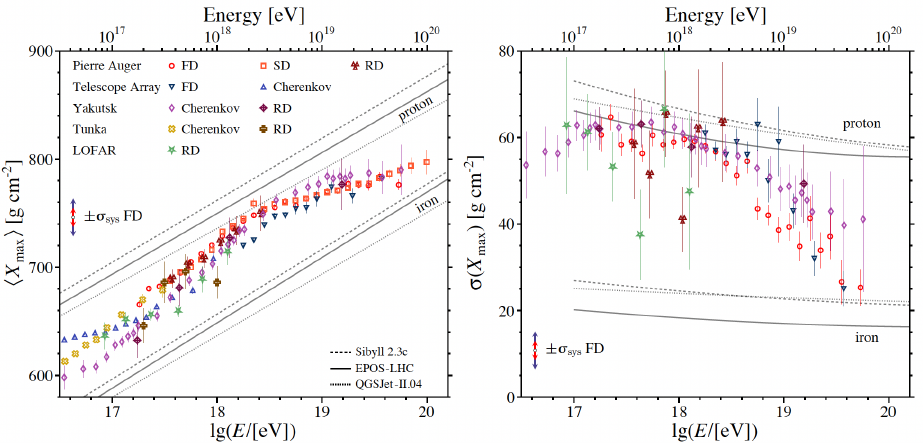
Figure 2. Measurements of the mean ( left ) and its fluctuations ( right ) of the distribution of shower maximum X max as function of energy, along with predictions for proton and iron nuclei based on hadronic interaction models. There is an apparent trend for the composition to become heavier towards highest energies. Systematic uncertainties of the fluorescence (FD) measurements of TA (Telescope Array) and PA (Auger) are indicated as blue and red arrows, respectively. From ref.